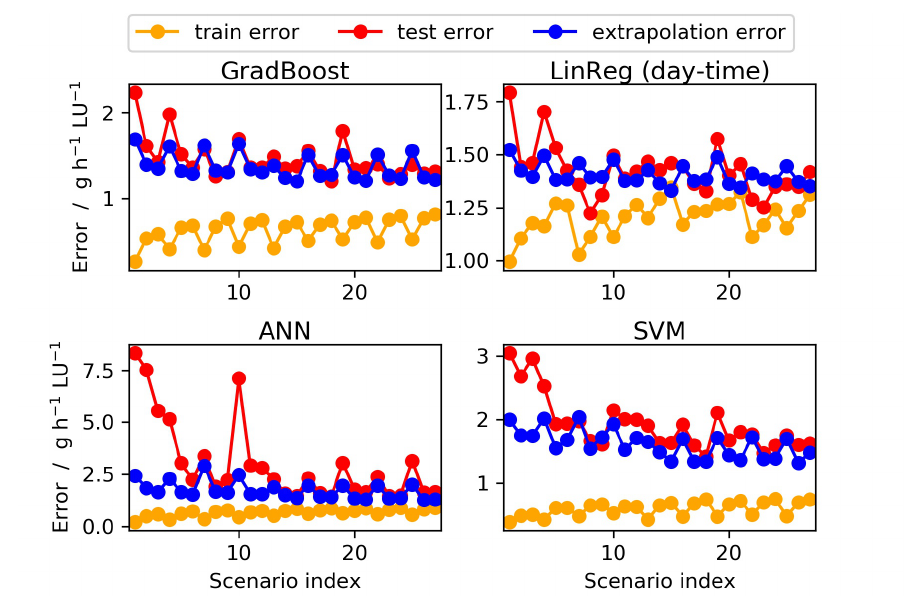
Figure 5. Mean absolute errors [g h − 1 LU − 1 ] for four distinct regression methods (where LinReg used only the sine and cosine transformed day-time feature and the other three methods used all features). In each case, the error was determined on three different datasets: The data that were used for learning (train error depicted in orange), the data that were used for model testing in the cross-validation (test error depicted in red) and the data that were not used in the cross-validation (extrapolation error depicted in blue). All error values were averaged over 30 realizations of data selection, which fulfill the scenario constraints. Please note that the y -axes in the subplots have different scaling.